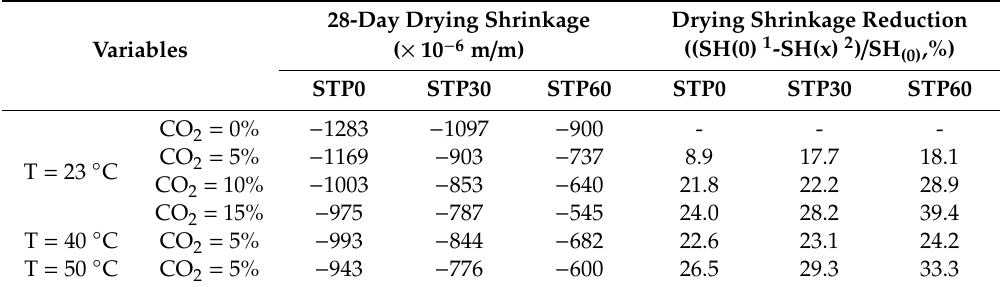
Table 3. 28-day drying shrinkage according to the curing